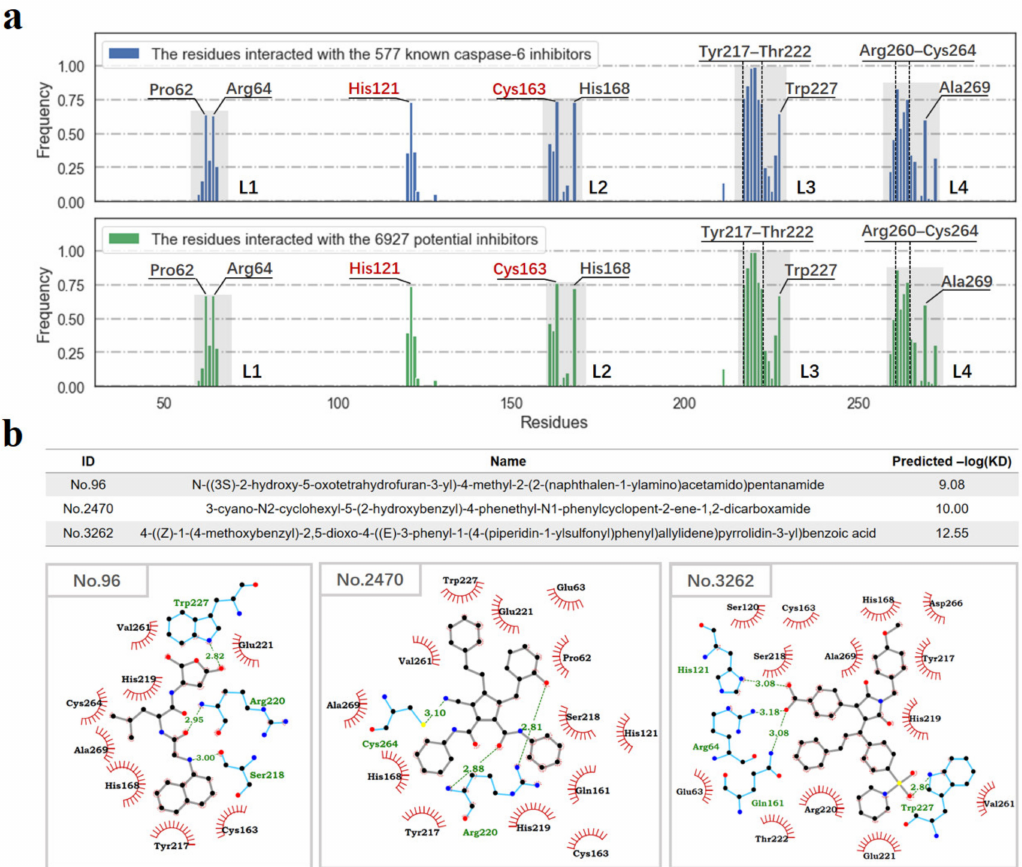
Figure 7. The binding modes of the 577 known caspase-6 inhibitors and 6927 potential inhibitors. ( a ) The occurrence frequencies of the binding residues involved in the intermolecular interactions with the binding ligands (the distance cutoff was set to 5 Å). The residues with the occurrence frequencies larger than 50% are marked, and the catalytic dyad residues His121 and Cys163 are colored in red. ( b ) Schematic diagrams of protein–ligand interactions of three representative samples. H-bonds are represented as green dashed lines. The carbon, nitrogen, oxygen, sulfur atoms are colored in black, blue, red and yellow,